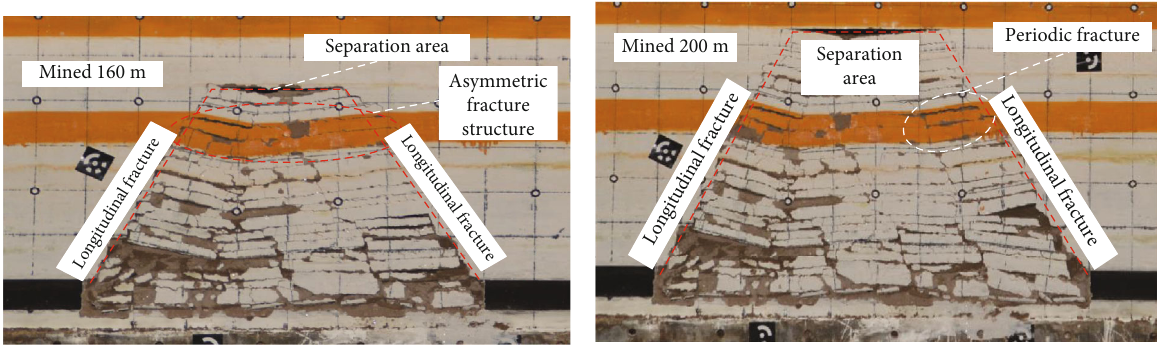
Figure 6: Fracture characteristics of lower key strata.